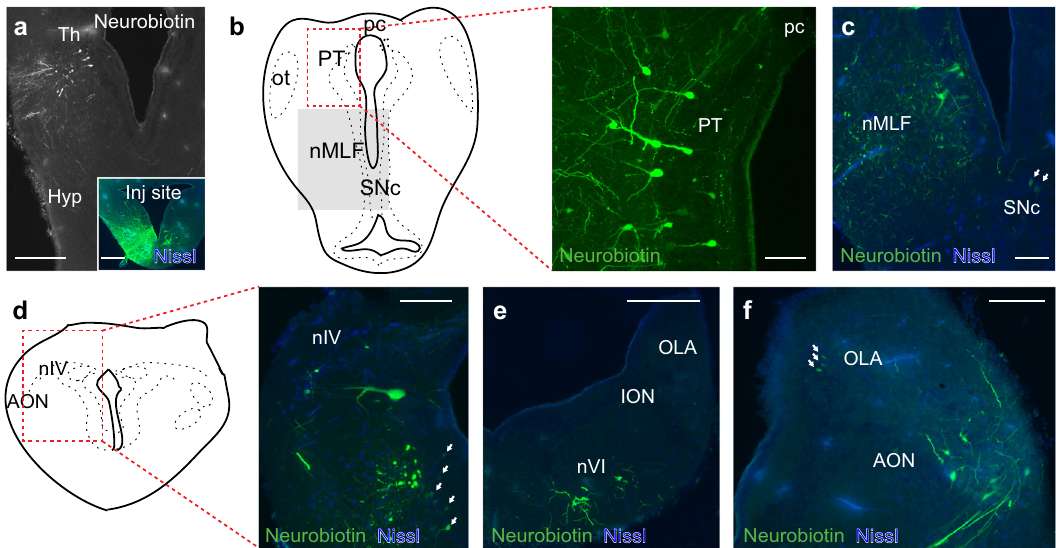
Fig. 5 | Visual and vestibular sources to the oculomotor nucleus. a Neurobiotin was injected in the oculomotor nucleus (inset), which showed ipsilateral projec- tions from thalamus. b Numerous retrogradely labeled cells were found in pre- tectum forming a population projecting to the ipsilateral oculomotor nucleus. c Retrogradely neurons in the region of the nMLF. Some retrogradely labeled neurons were also observed in the SNc (arrows). d , e Projections were also found from the two other cranial nerve nuclei responsible for extraocular muscle inner- vation, illustrated here by a cell population in the trochlear nucleus ( d ) and con- tralateral abducens nucleus ( e ). Retrogradely labeled neurons were also found in